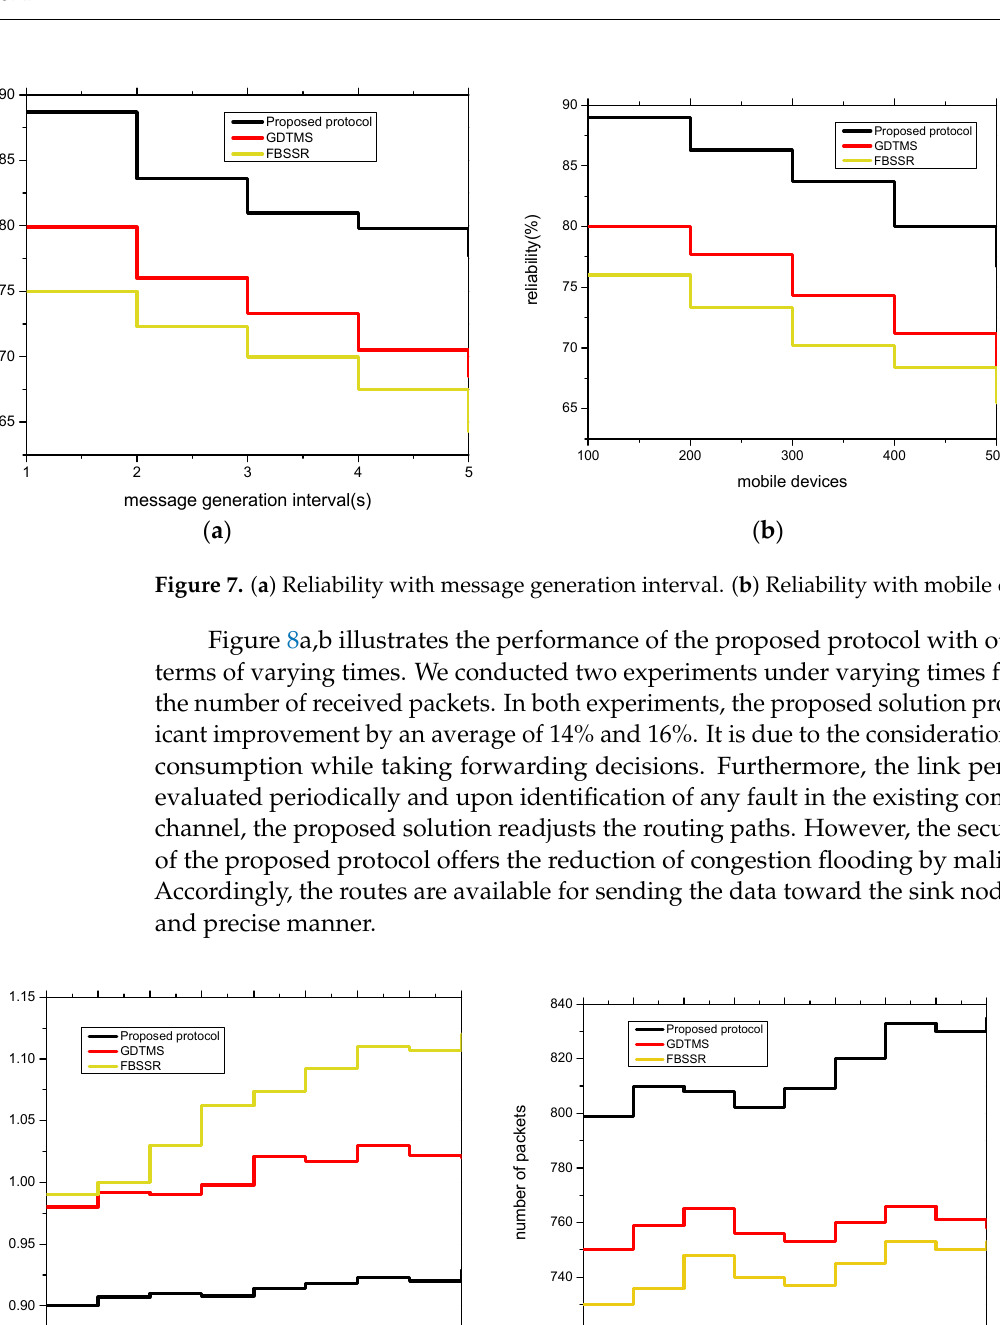
Figure 8. ( a ) Delay with varying time. ( b ) Number of packets with varying time.